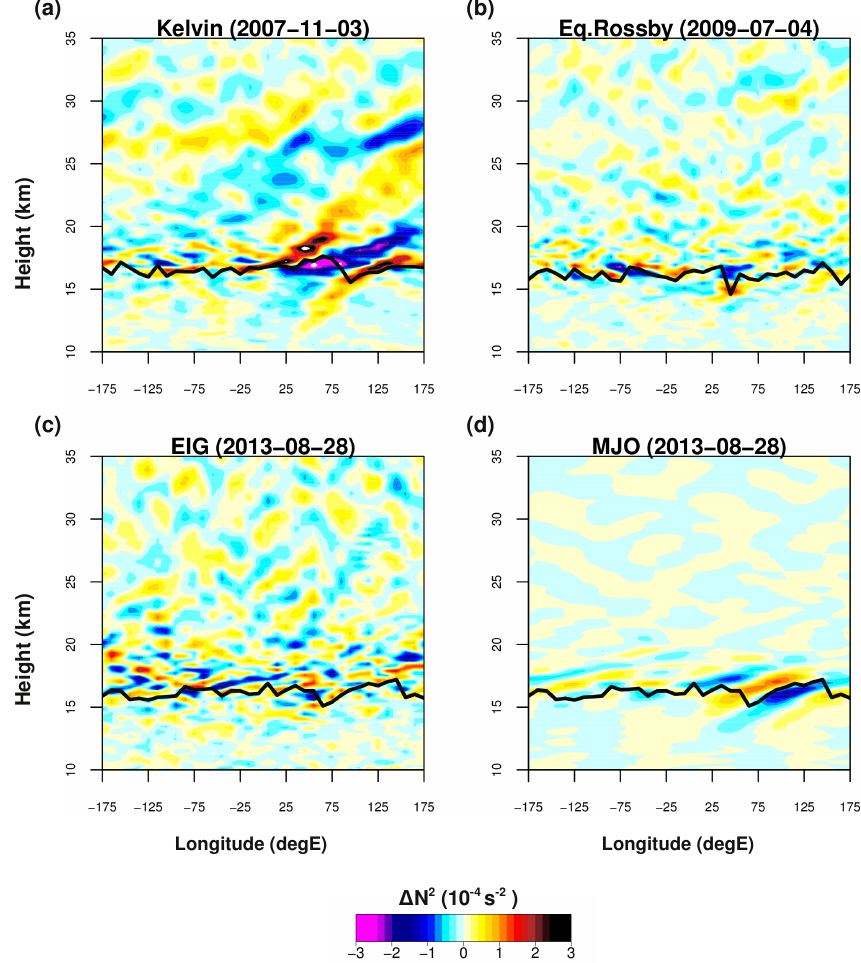
Figure 5. Longitude–height snapshots of static stability anomalies ( (cid:49)N 2 ) of different wave types at certain dates: (a) Kelvin wave, (b) Rossby wave, (c) eastward IGW (EIG n ), (d) MJO band. The black line denotes the thermal tropopause.